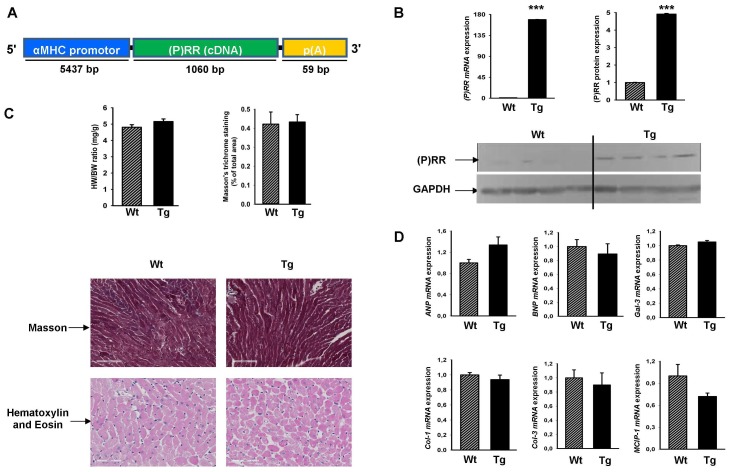
Generation of (P)RR transgenic mice and baseline characteristics.A) Schematic depiction of the generation of Tg mice with cardiomyocyte-restricted (P)RR overexpression. We cloned the 1060 bp murine (P)RR cDNA in front of the a 5.5-kb α-MHC promoter. B) (P)RR mRNA expression normalized to 36B4 by RT-PCR of Tg mice and their Wt littermates (left upper panel); western blot for (P)RR and GAPDH protein from hearts of Tg and Wt mice (bottom panel) and quantification of the western blot (right upper panel). C) Heart-weight (HW) normalized to body weight (BW) in adult Wt and Tg mice (left upper panel); images for Masson staining for quantification of fibrosis (bar size 100 µm) and haematoxylin and Eosin staining (bar size 70 µm) for assessment of cardiac morphology (bottom pannels) and quantification of Masson staining (right upper panel). D) mRNA expression of ANP, BNP, Gal-3, Col-1, Col-3, and MCIP1 (normalized to 36B4) of the Wt and Tg mice. Fold changes are shown. *** P<0.001, Wt vs. Tg.